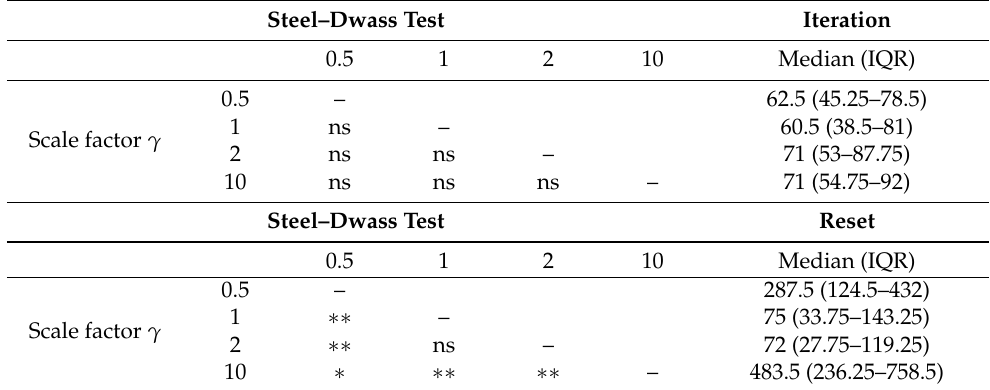
Table 3. Learning characteristics of the QNN concerning the feedback